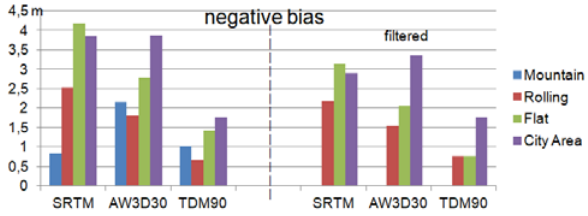
Figure 5. Negative Z-bias against LiDAR DTM for the